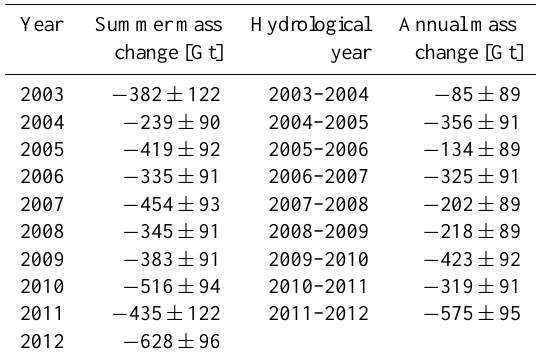
Table 3. Summer and annual mass changes from GRACE for the period